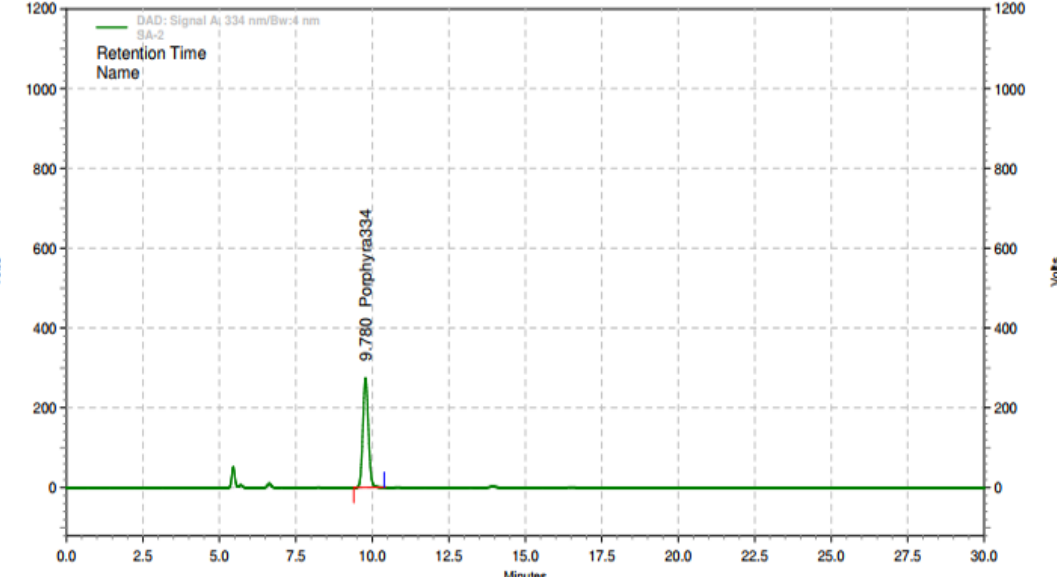
Figure 1. Representative chromatograms of Porphyra tenera extract (PTE) based on high-performance liquid chromatography (HPLC) analysis of porphyra34 in